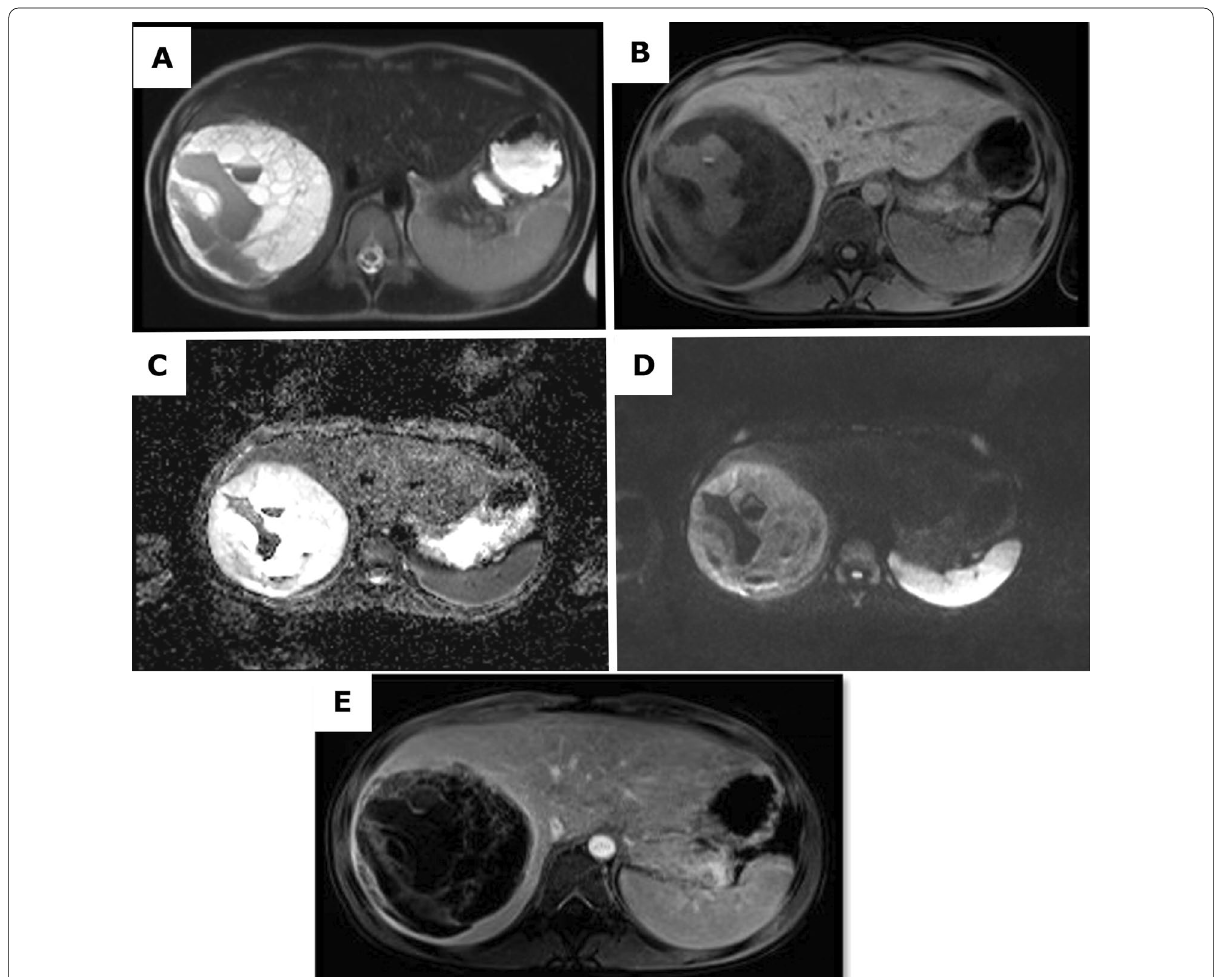
Fig. 3 A Axial T2WI MRI, B T1WI shows internal areas of high signal in T1 and corresponding shading signal in T2 denoting hemorrhagic element. C , D ADC and DWI with b value 800 show no restriction diffusion. E Axial T1WI arterial post-contrast shows enhanced internal